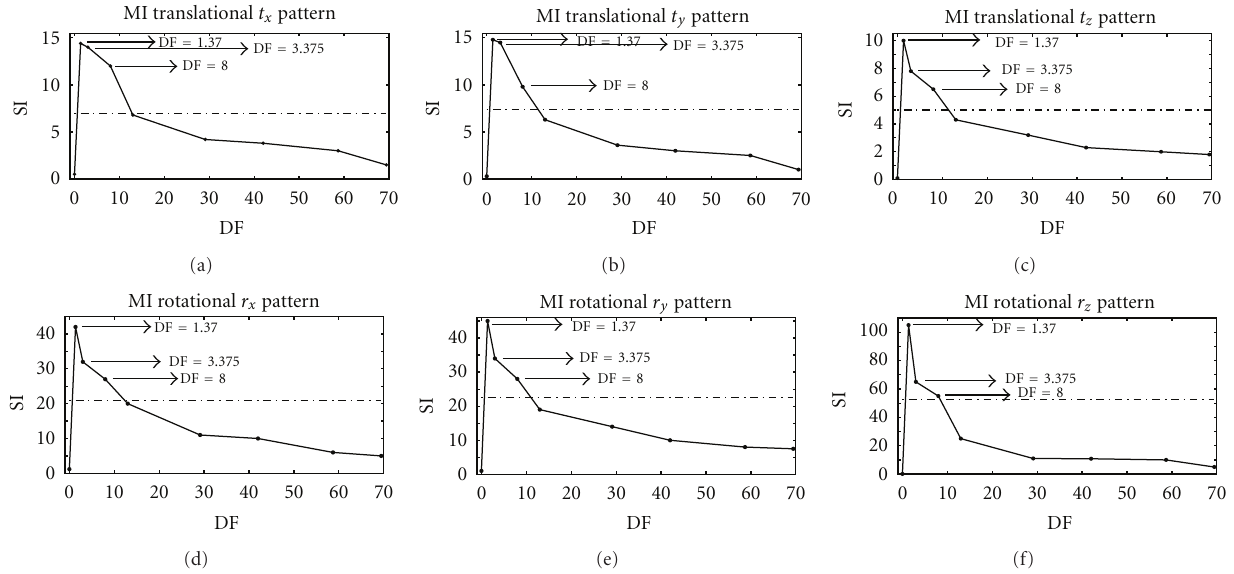
Figure 3: SI values for di ff erent DF values. The first row shows the SI values corresponding to the translational t x , t y , and t z MI patterns. The second row shows the SI values corresponding to the rotational r x , r y , and r z MI